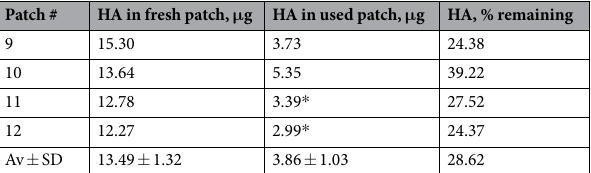
Figure 2. Humoral immune responses in pregnant mice immunized with A/Brisbane/59/07 H1N1 subunit vaccine via intramuscular or transcutaneous routes. Anti-influenza binding antibodies were determined by ELISA in sera collected from mice 28 days after immunization. ( A ) IgG ( B ) IgG1 and ( C ) IgG2a antibody titers. Values are expressed as mean ± SEM, (n = 5–20). ( D ) † Hemagglutination inhibition (HAI) and ( E ) neutralizing antibody (NT) titers in sera collected 28 days after immunization. Values are expressed as geometric mean with a ± 95% confidence interval (n = 5–20). † Naive: unimmunized mice; IM: vaccine administered intramuscularly; ID: vaccine administered intradermally with syringe and needle; MN: microneedle patches encapsulating the vaccine. † [Pregnant mice: MN (2.5 µ g), n = 14; IM (5 μ g), n = 8; IM (2.5 μ g), n = 5; ID (2.5 μ g), n = 5; naïve, n = 5. Non-pregnant mice: MN (2.5 µ g), n = 20; IM (5 µ g), n = 20; IM (2.5 µ g), n = 5; ID (2.5 µ g), n = 5; naïve, n = 5]. a [MN vs IM (5 μ g), IM (2.5 μ g), and ID (2.5 μ g)]. b [IM (5 μ g) vs IM (2.5 μ g), and ID (2.5 μ g)]. * p < 0.05; ** p < 0.01; *** p < 0.001; **** p < 0.0001. Data were analyzed with Mann-Whitney unpaired non-parametric